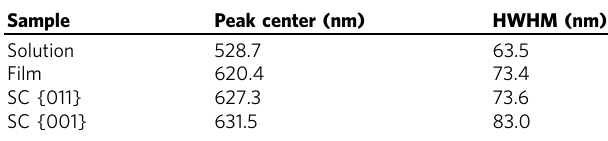
Table 1 Plasmon peak position and width of gold SC